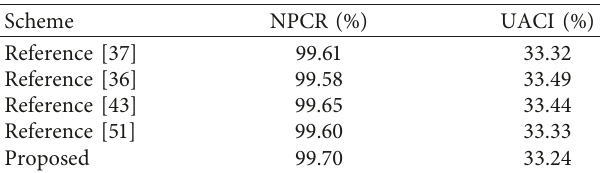
Table 9: Comparison of NPCR and UACI between different schemes for the encrypted Lena